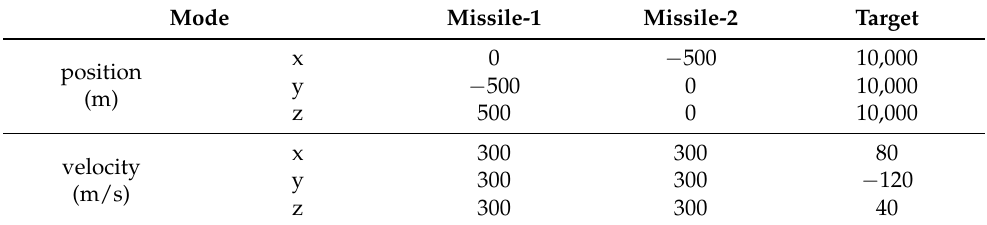
Table 1. Initial